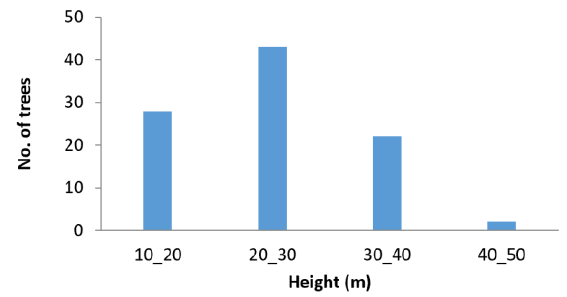
Figure 9. Number of trees according to tree height